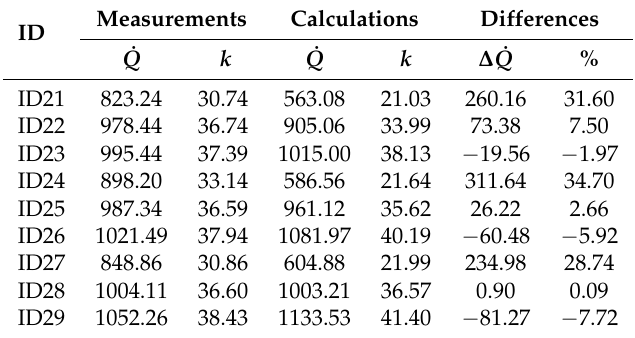
Table 11. Comparison of measurements and analytical calculations. Measurements Calculations Differences ID